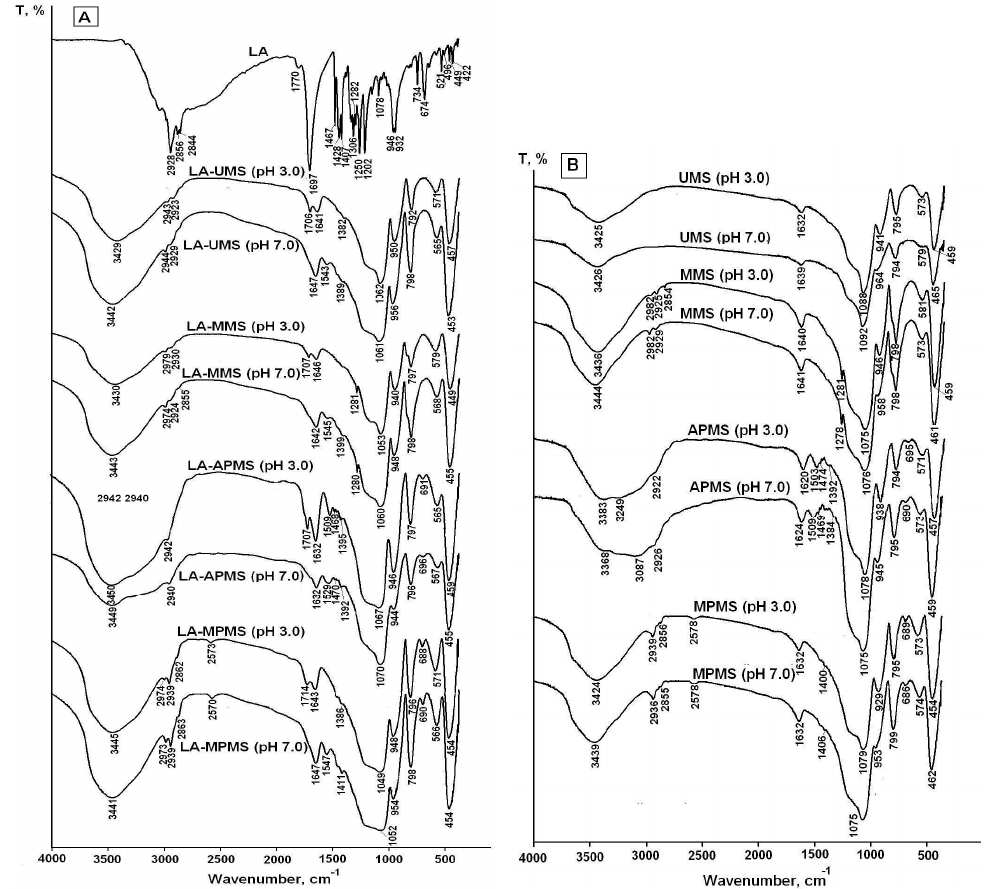
Figure 2. FTIR spectra of crystal LA and LA-silica composites ( A ) and silica matrixes ( B ) synthesized at sol-gel synthesis pH 3 and 7. Table 2. Assignment of FTIR bands in the spectrum of crystal LA.